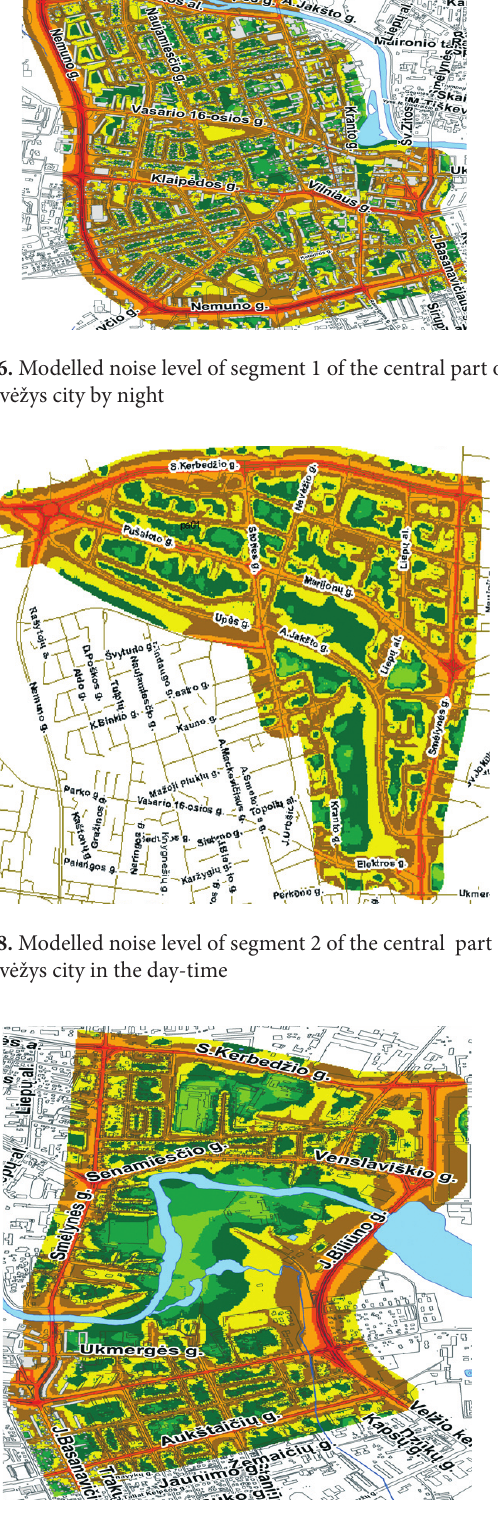
Fig. 10. Modelled noise level of segment 3 of the central part of Panevėžys city in the day-time